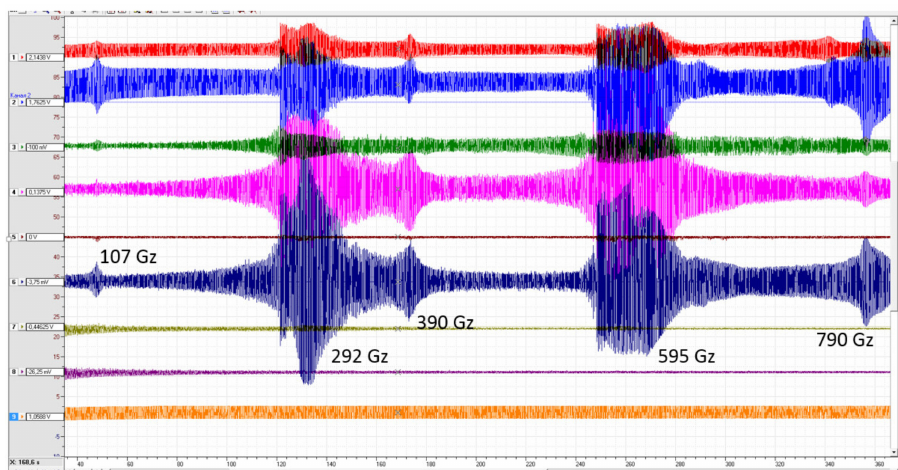
Figure 12. Visualization of the process of measuring the PEG output characteristics during sweeping. Table 7. Experimental measurements of the voltage amplitude on the PE electrodes at the correspond- ing vibration frequencies and the corresponding active electric load.